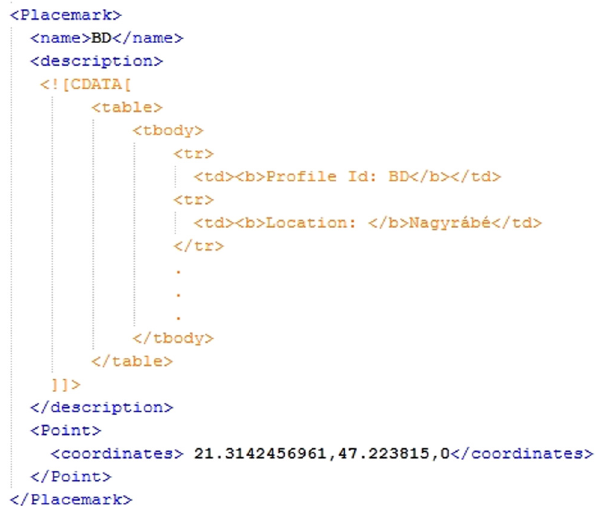
Figure 4: Details of the KML template